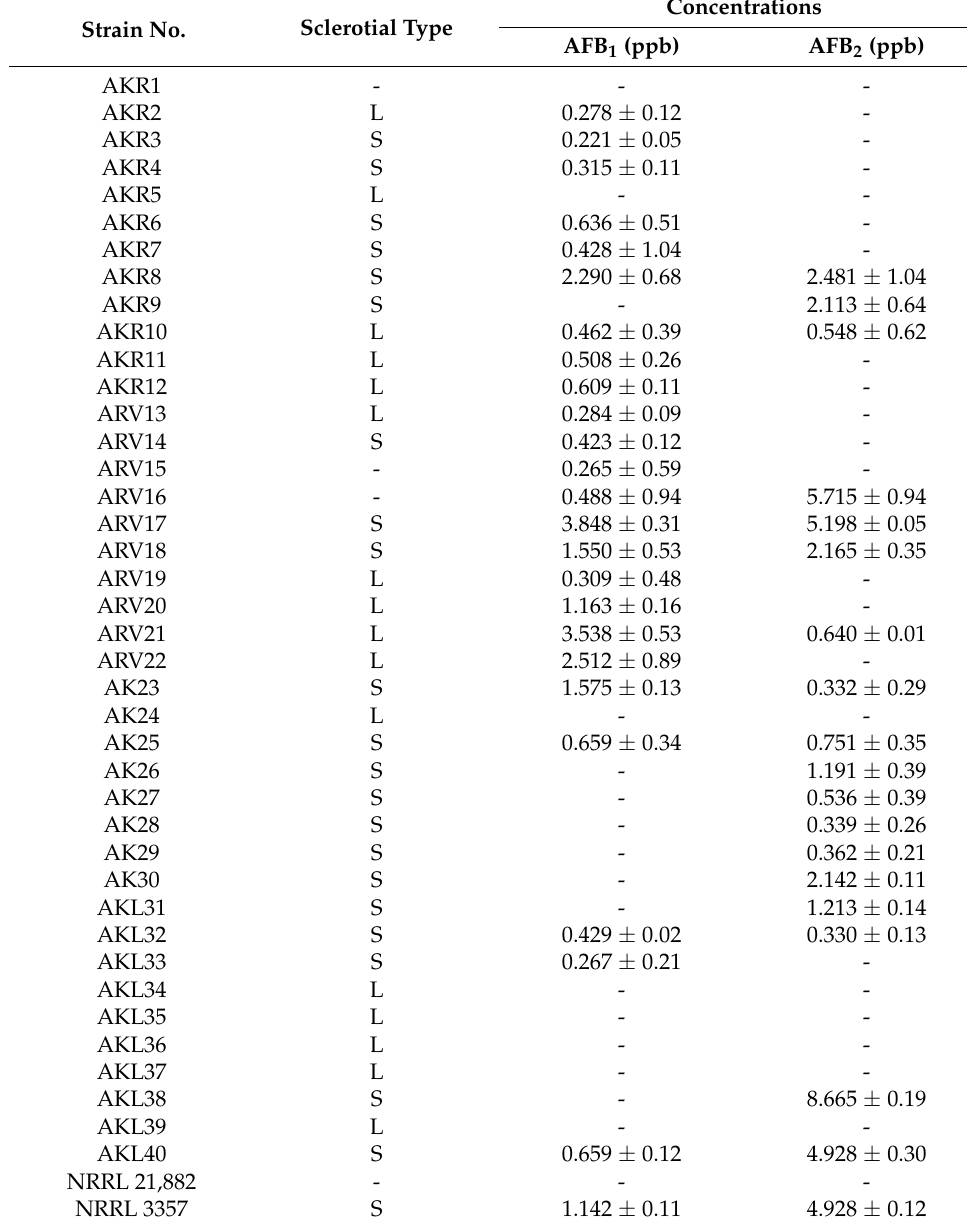
Table 3. The concentrations of AFB 1 and AFB 2 produced by A. flavus . Strain No. Sclerotial